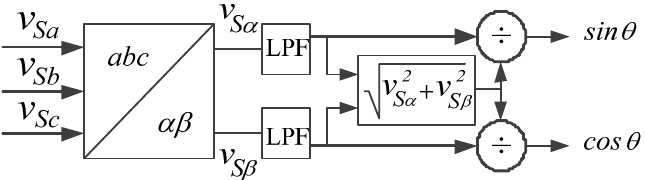
Figure 3. Block diagram of the unit vector generation.